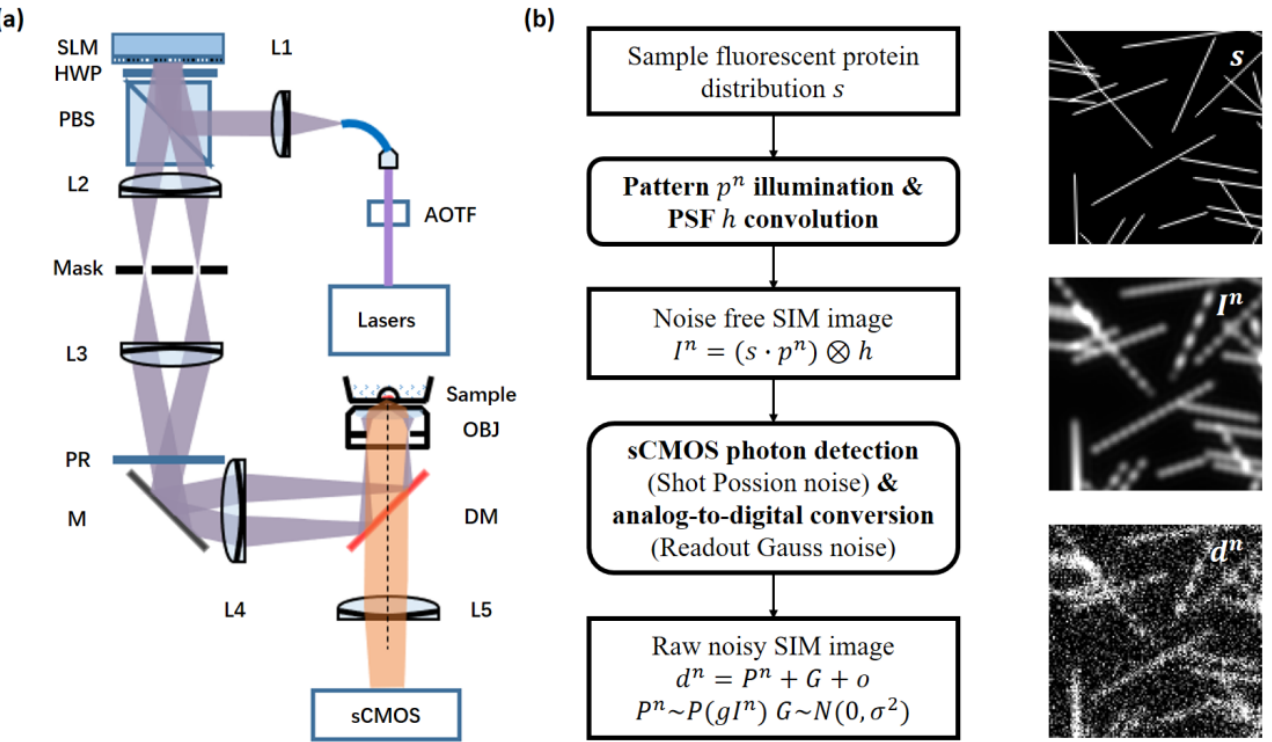
Figure 1. Diagram of sCMOS camera noise in SIM. ( a ) Schematic diagram of the SIM setup. PBS, polarization beam splitter; AOTF, acousto-optic tunable filters; HWP, half wave-plate; DM, dichroic mirror; SLM, spatial light modulator; PR, polarization rotator; L1–L5, lenses. ( b ) SIM imaging model and sCMOS camera noise model.